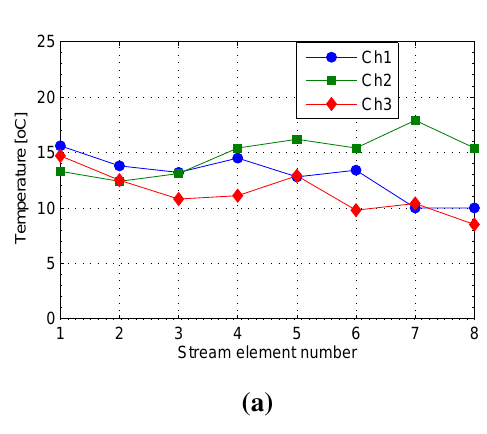
Figure 4. One-dimensional stream results. ( a ) Snapshot of the first values of member nodes; ( b ) average cluster